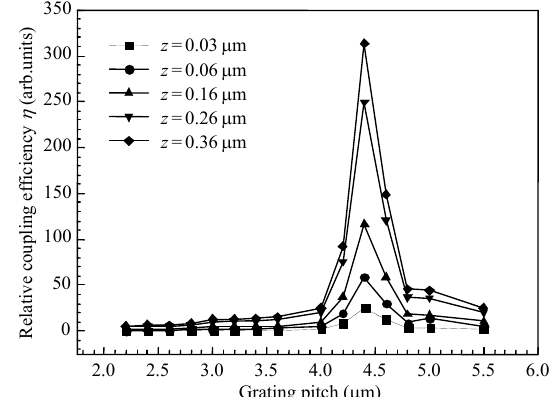
Fig. 4 Relative coupling efficiency with respect to grating pitch.